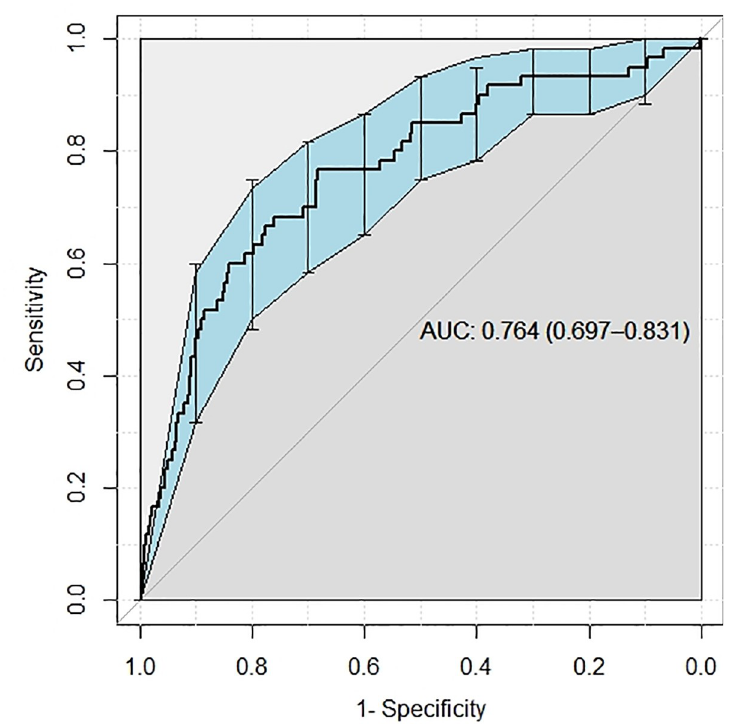
Fig 2. Receiver operator curve to detect COVID test positivity among those who had a negative COVID test on admission and were retested.